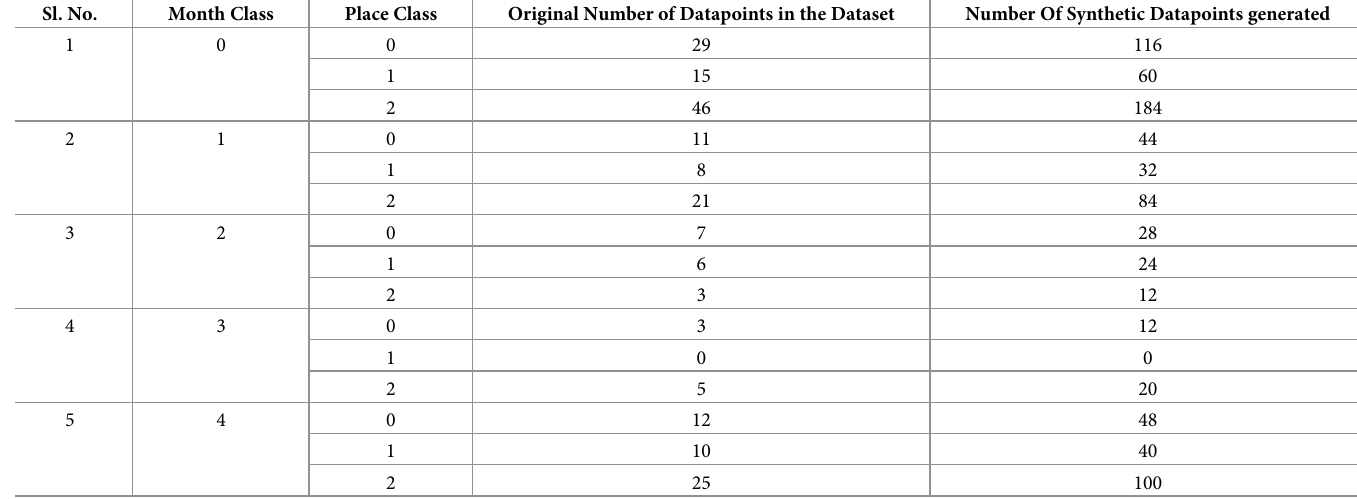
Table 4. Synthetic data generation using the MC technique where the mean and covariance matrices are not shared between the classes. Sl. No.